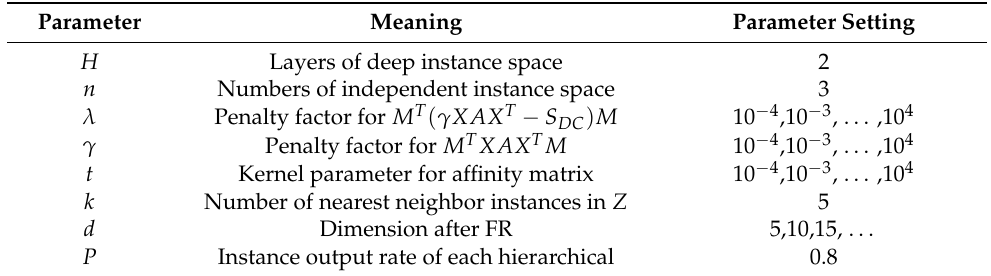
Table 2. Parameter description and